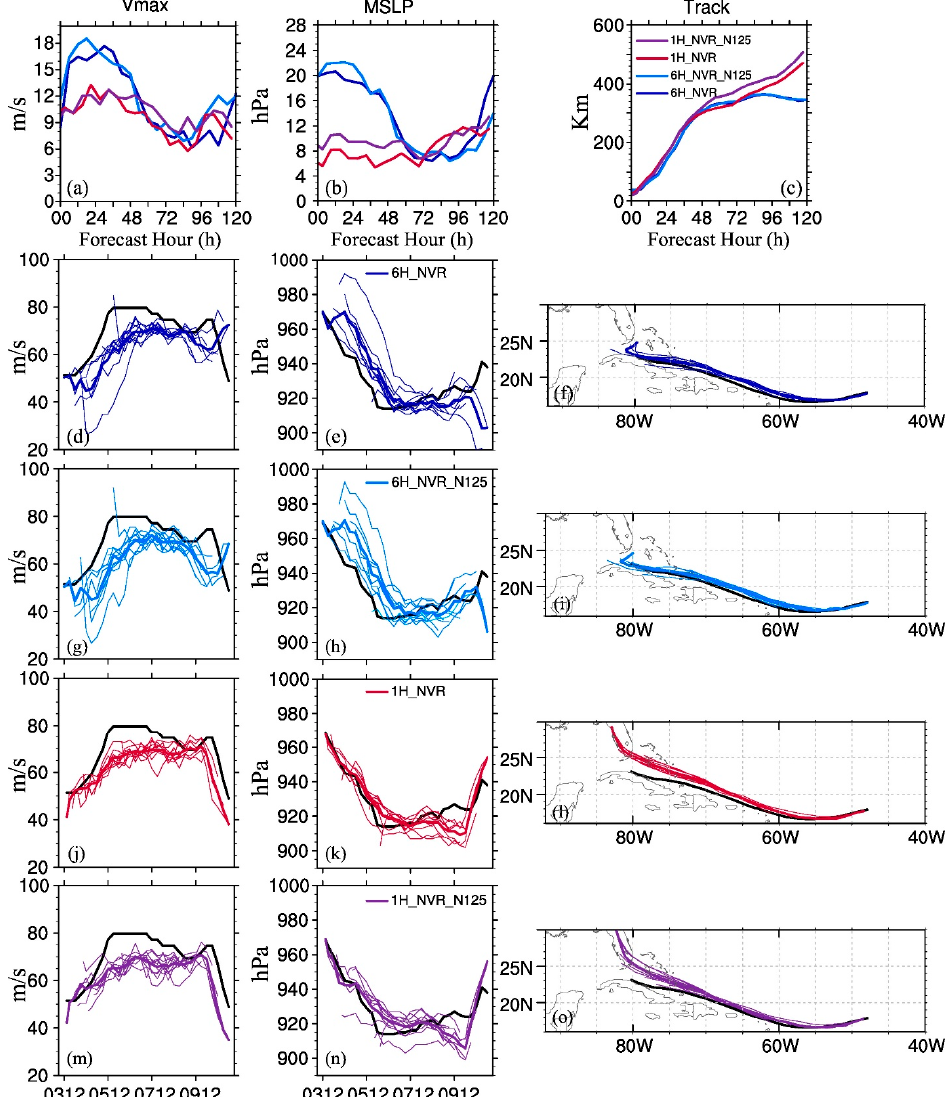
Figure 2. ( a ) Vmax, ( b ) MSLP, and ( c ) Track prediction RMSE for “1H_NVR” (red), “1H_NVR_N125” (purple), “6H_NVR” (blue), and “6H_NVR_N125” (turquoise). ( d – o ) show the individual forecast for each experiment for ( d , g , j ), and ( m ) Vmax, ( e , h , k , n ) MSLP, and ( f , i , l , o ) Track predictions and verification with the best track (black). The average of forecasts valid at each synoptic time is shown in bold color lines for each experiment for reference.